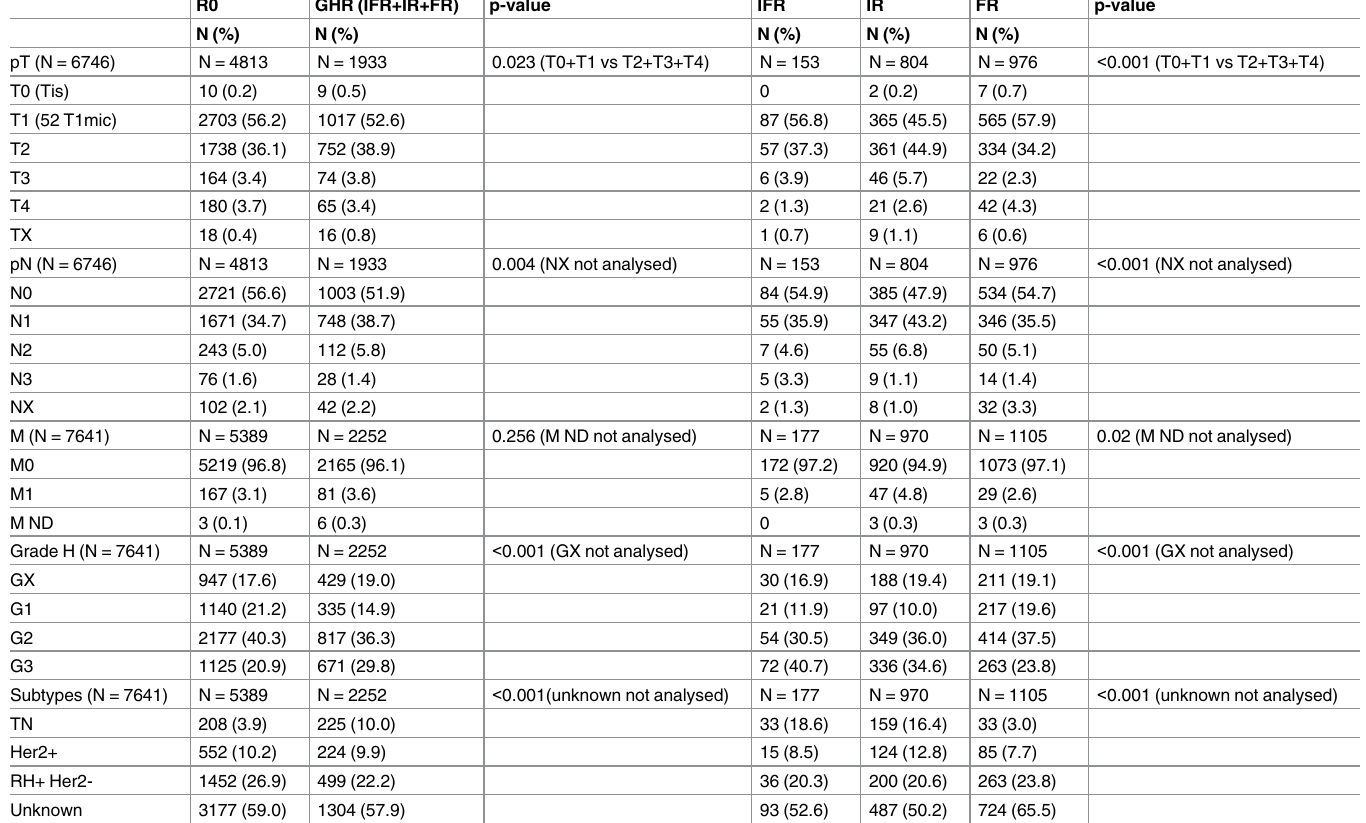
Table 3. Description of the TNM, histological subtype and grade of the evaluable patients, including TN patients. Only pathological T and N were